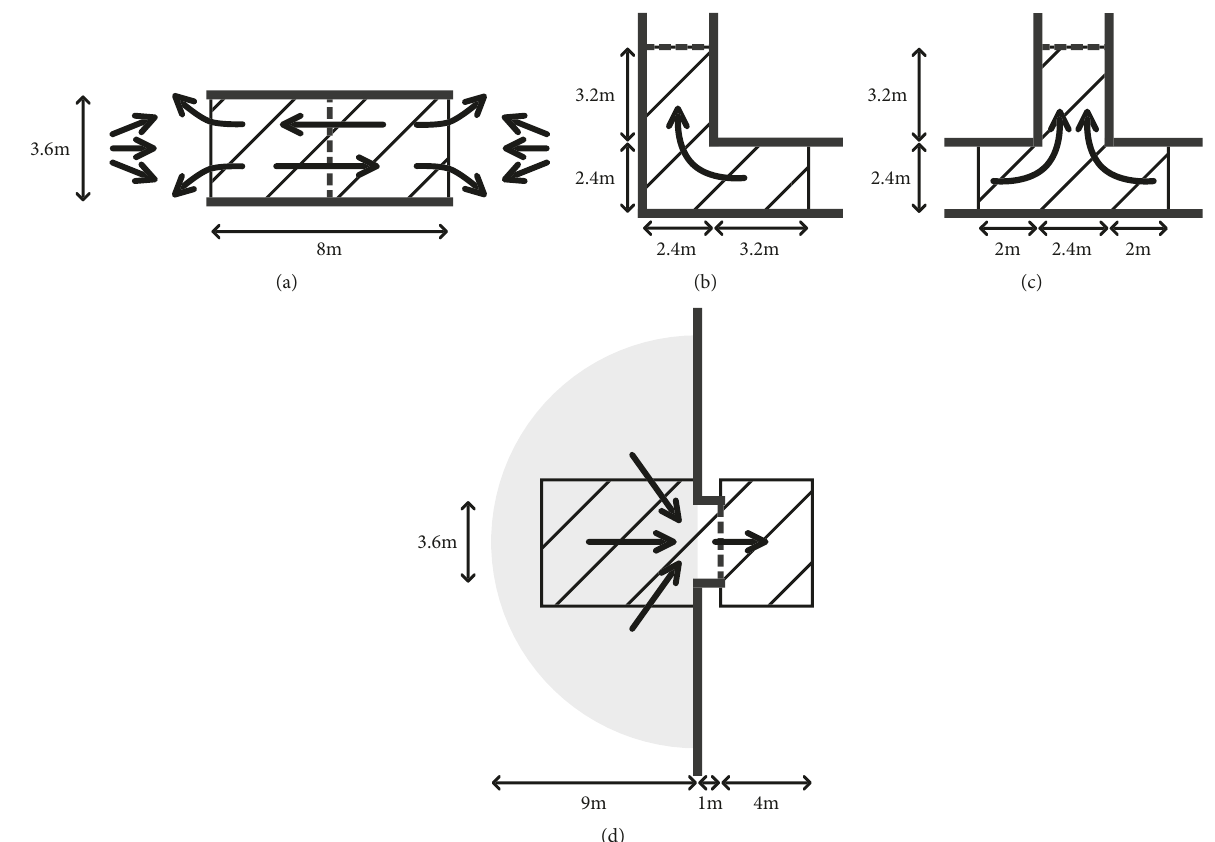
Figure 4: Overview of the layout of the four movement base cases used during the calibration. (a) Bidirectional flow. (b) Unidirectional corner flow. (c) Merging t-junction flow. (d) Bottleneck. In the figure the hatched areas indicate the measurement areas; the dashed lines the location where the flow is measured and in the case of the bottleneck the grey area indicates the waiting area at the start of the simulation.